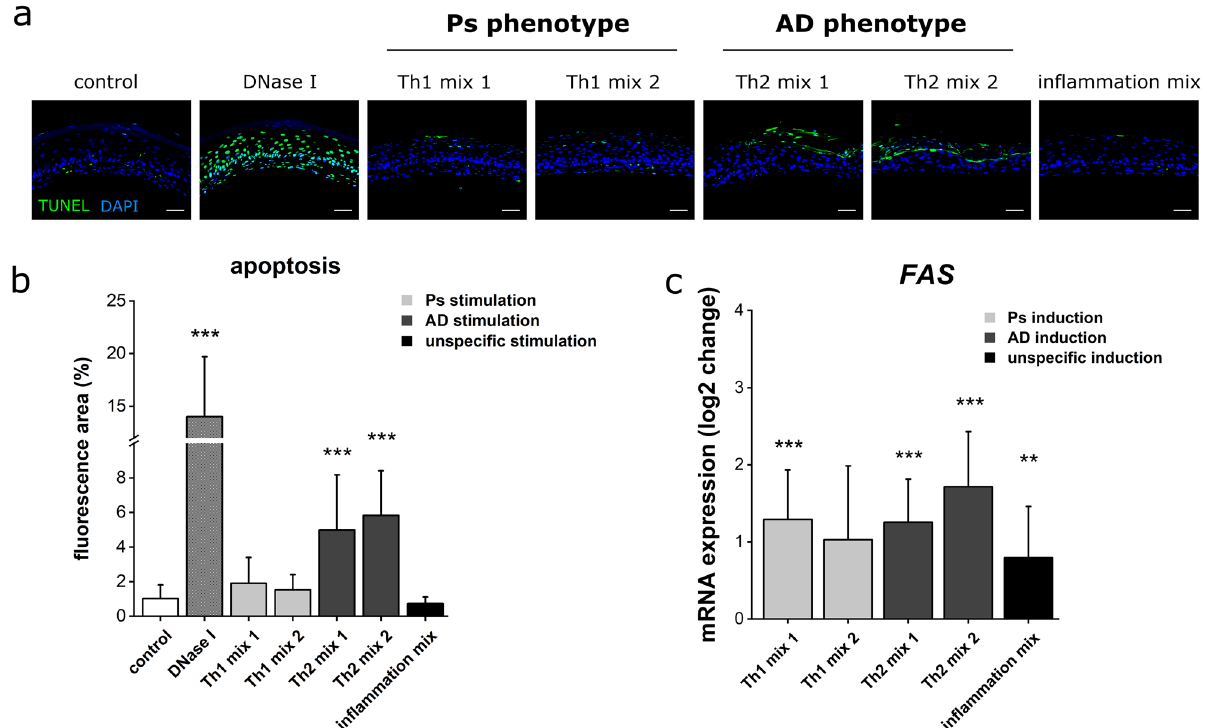
staining (green fluorescence). DAPI was used for nuclear staining (blue fluorescence). ( b ) Quantification of apoptotic TUNEL fluorescence area (mean + SD) of n = 2 experiments with a total of 4 skin models (keratinocytes derived from one donor) presented as % per skin model. Statistics: Mann–Whitney U test; p ≤ 0.05 *, p ≤ 0.01 **, p ≤ 0.001 *** compared to control. ( c ) Log2 change of mRNA expression of the FAS cell death receptor gene was determined by real-time qPCR. Values are mean + SD of n = 2 experiments with a total of 4 skin models. Statistics: Mann–Whitney U test; p ≤ 0.05 *, p ≤ 0.01 **, p ≤ 0.001 *** compared to